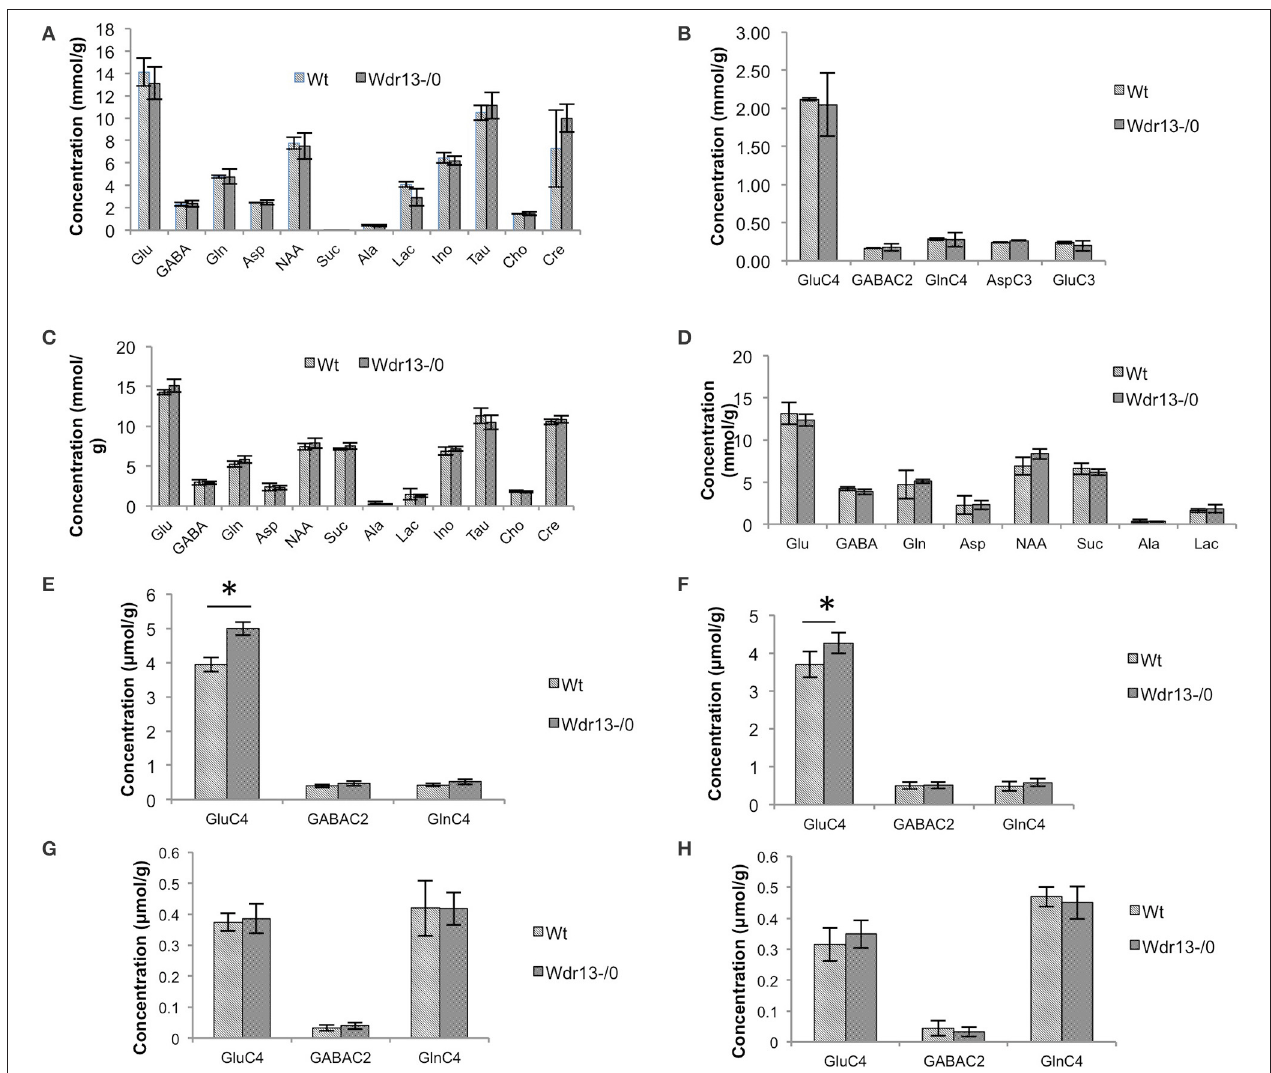
FIGURE 2 | (A,B) Analysis of brain metabolites using NMR of 2 month old Wdr13 − / 0 and wild-type mice ( n = 4) (A) . Concentration of metabolites in cerebral cortical extract of mice using [2-13C]glycine as reference. (B) 13C labeled metabolites in cortex from [1,6-(13)C(2)]glucose of 2 months old Wdr13 − / 0 mice showed no significant difference ( p > 0.05) than the wild-type mice. Data is represented ± SD. (C–H) Analysis of brain metabolites using NMR of 10 month old Wdr13 − / 0 and wild-type mice ( n = 5, 6) (C) . Concentration of metabolites in cerebral cortical extract of mice using [2-13C]glycine as reference. (D) Concentration of metabolites in cerebral sub-cortical extract of mice using [2-13C]glycine as reference. (E) 13C labeled metabolites enriched from [U-13C6]glucose in cortex showed significant increase ( p < 0.05) in levels of glutamate C4 (GluC4) in Wdr13 − / 0 mice than the wild-type mice. (F) 13C labeled metabolites enriched from [U-13C6]glucose in subcortex also showed significant increase ( p < 0.05) in levels of glutamate C4 in the Wdr13 − / 0 mice. (G) 13C labeled metabolites from [2-13C]acetate in cortex and in (H) Subcortex did not show any significant differences ( p > 0.05) between Wdr13 − / 0 and wild-type mice. Data represented as ± SEM. Wt, wild-type; Wdr13 − / 0 , Wdr13 knockout mice; Glu, Glutamate, GABA; Gln, Glutamine; Asp, Aspartate; NAA, N-AcetylAspartate; Suc, Succinate; Ala, Alanine; Lac, Lactate; Ino, Inositol; Tau, Taurine; Cho, Choline; Cre, Creatinine or Cre. * p < 0.05.